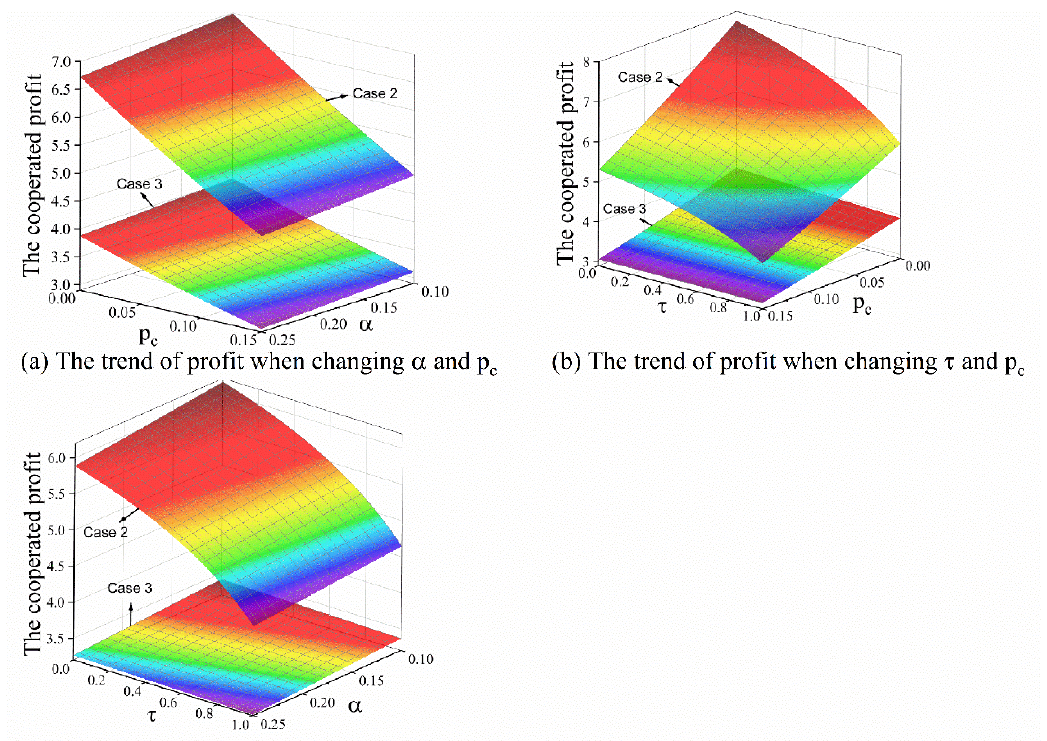
Figure 13. The thermal power generating company’s profits under different levels of α , τ , and p c